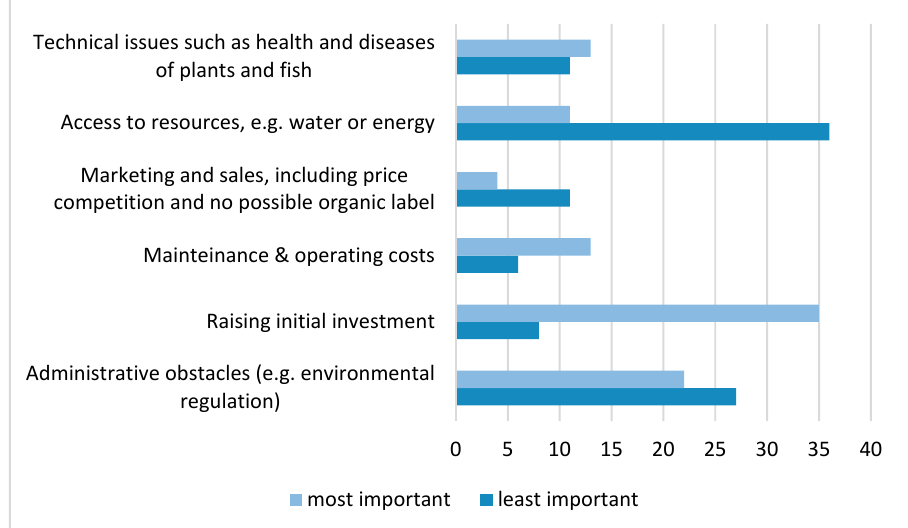
Figure 4. Main challenges of commercial aquaponics as perceived by the European responders (N = 60). Answers to the question: Relating to the project’s life cycle, what main difficulties have you